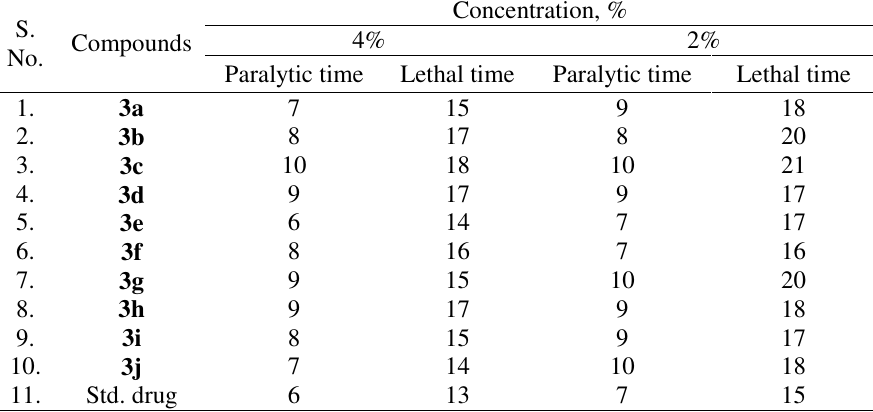
Table 3. Anthelmintic activity of compounds 3a-j (in